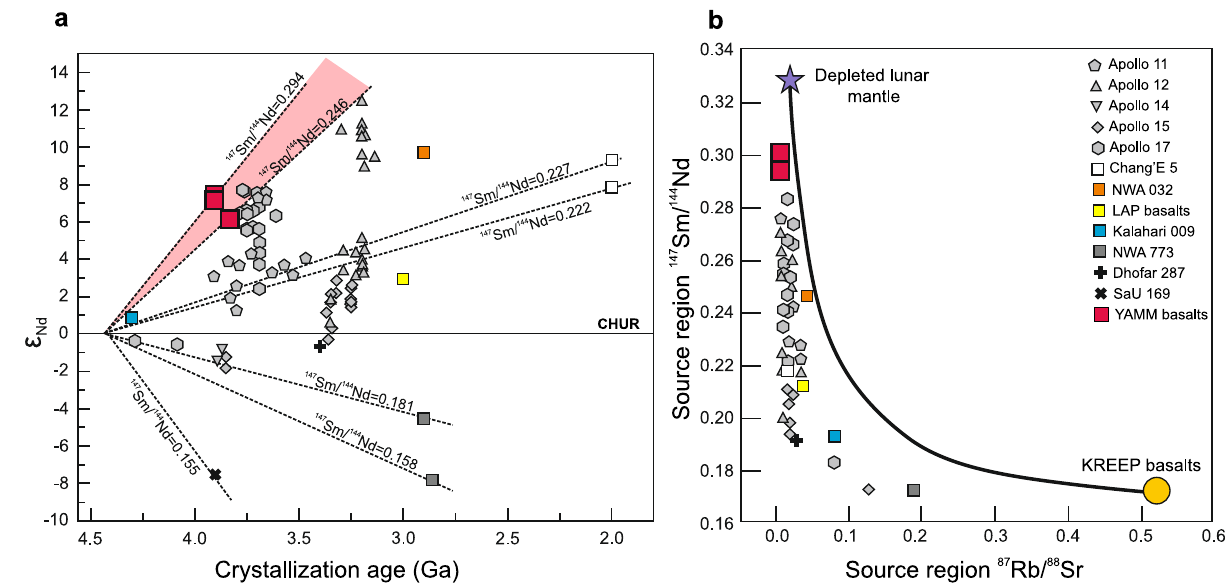
Fig. 2 | Sm-Nd and Rb-Sr source isotopic characteristics of YAMM meteorites and other lunarbasalts.a Plot of age (Ga, billion years) against ε Nd composition showing the depleted nature of YAMM meteorites in comparison to other lunar meteorites and Apollo mare basalts. ε Nd ( t )= (( 143 Nd/ 144 Nd)sample( t )/( 143 Nd/ 144 Nd) CHUR − 1)×10,000, where( 143 Nd/ 144 Nd)sample( t )and( 143 Nd/ 144 Nd) CHUR are the Ndisotopiccompositionsofsample andChondriticUniform Reservoir (CHUR) at time ( t ) of crystallization of the rock, respectively. b Calculated present day values of 147 Sm/ 144 Nd plotted against the present day 87 Rb/ 86 Sr for the source